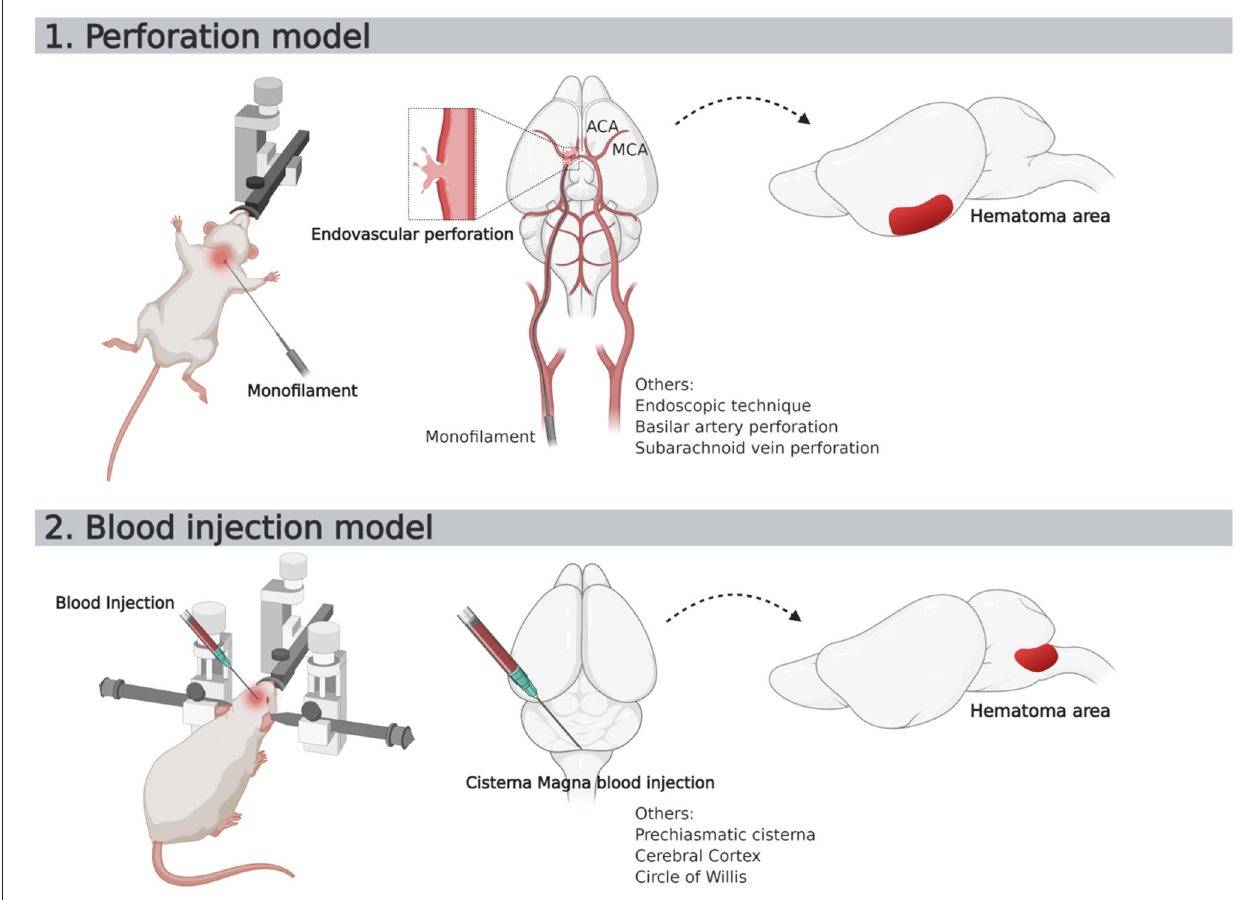
FIGURE 5 | Schematic representation of two most used SAH murine models. ACA, Anterior Cerebral Artery; MCA, Middle Cerebral Artery.